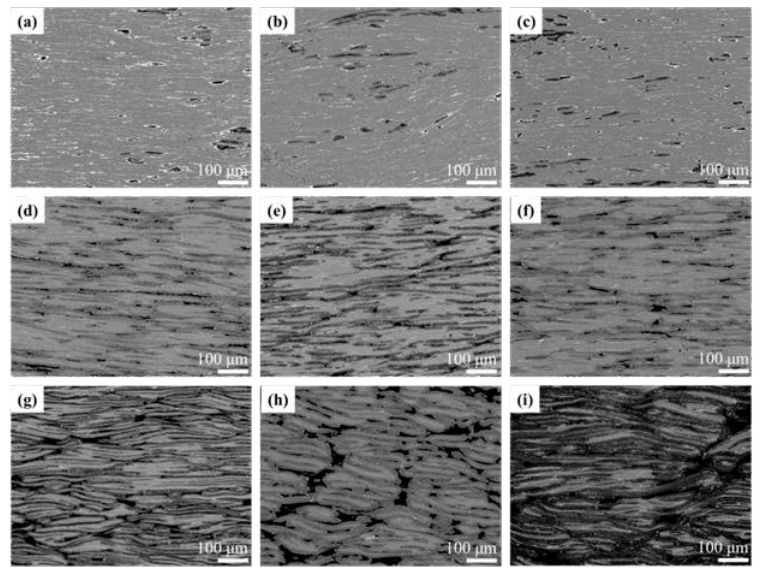
Figure 7. Sample morphology of orthogonal experiment, ( a – i ) experiments 1 – 9, respectively.